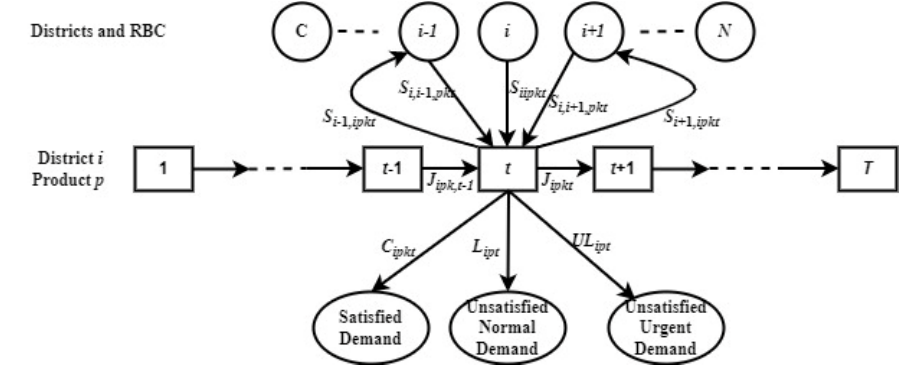
Fig. 4. The flow structure of product 𝑝 at district 𝑖 for Strategy